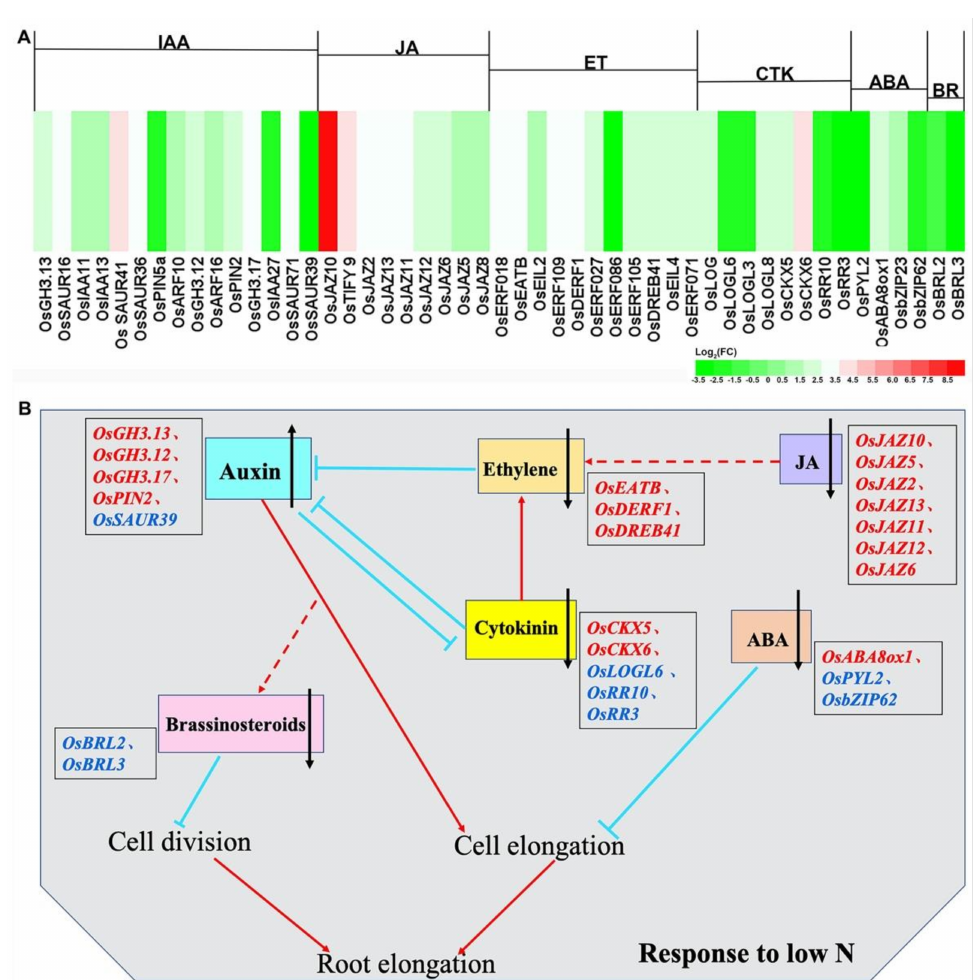
Figure 6. Expression profiles of genes associated with plant hormone signal transduction. ( A ) Heatmaps show the gene expression patterns related to IAA, JA, ET, CTK, ABA, and BR using log 2 fold change (FC) values; ( B ) genes involved in plant hormonal pathways to regulate root elonga- tion after low N stress. Genes marked in red/blue represented upregulation and downregulation, respectively. IAA: indole-3-acetic acid, JA: jasmonic acid, ET: ethylene, CTK: cytokinin, ABA: abscisic acid, BR: brassinosteroids. FPKM: fragments per kilobase of transcript per million fragments mapped. Red arrows, blue blunted lines, and red dashed lines indicate positive, negative, and synergistic effects,